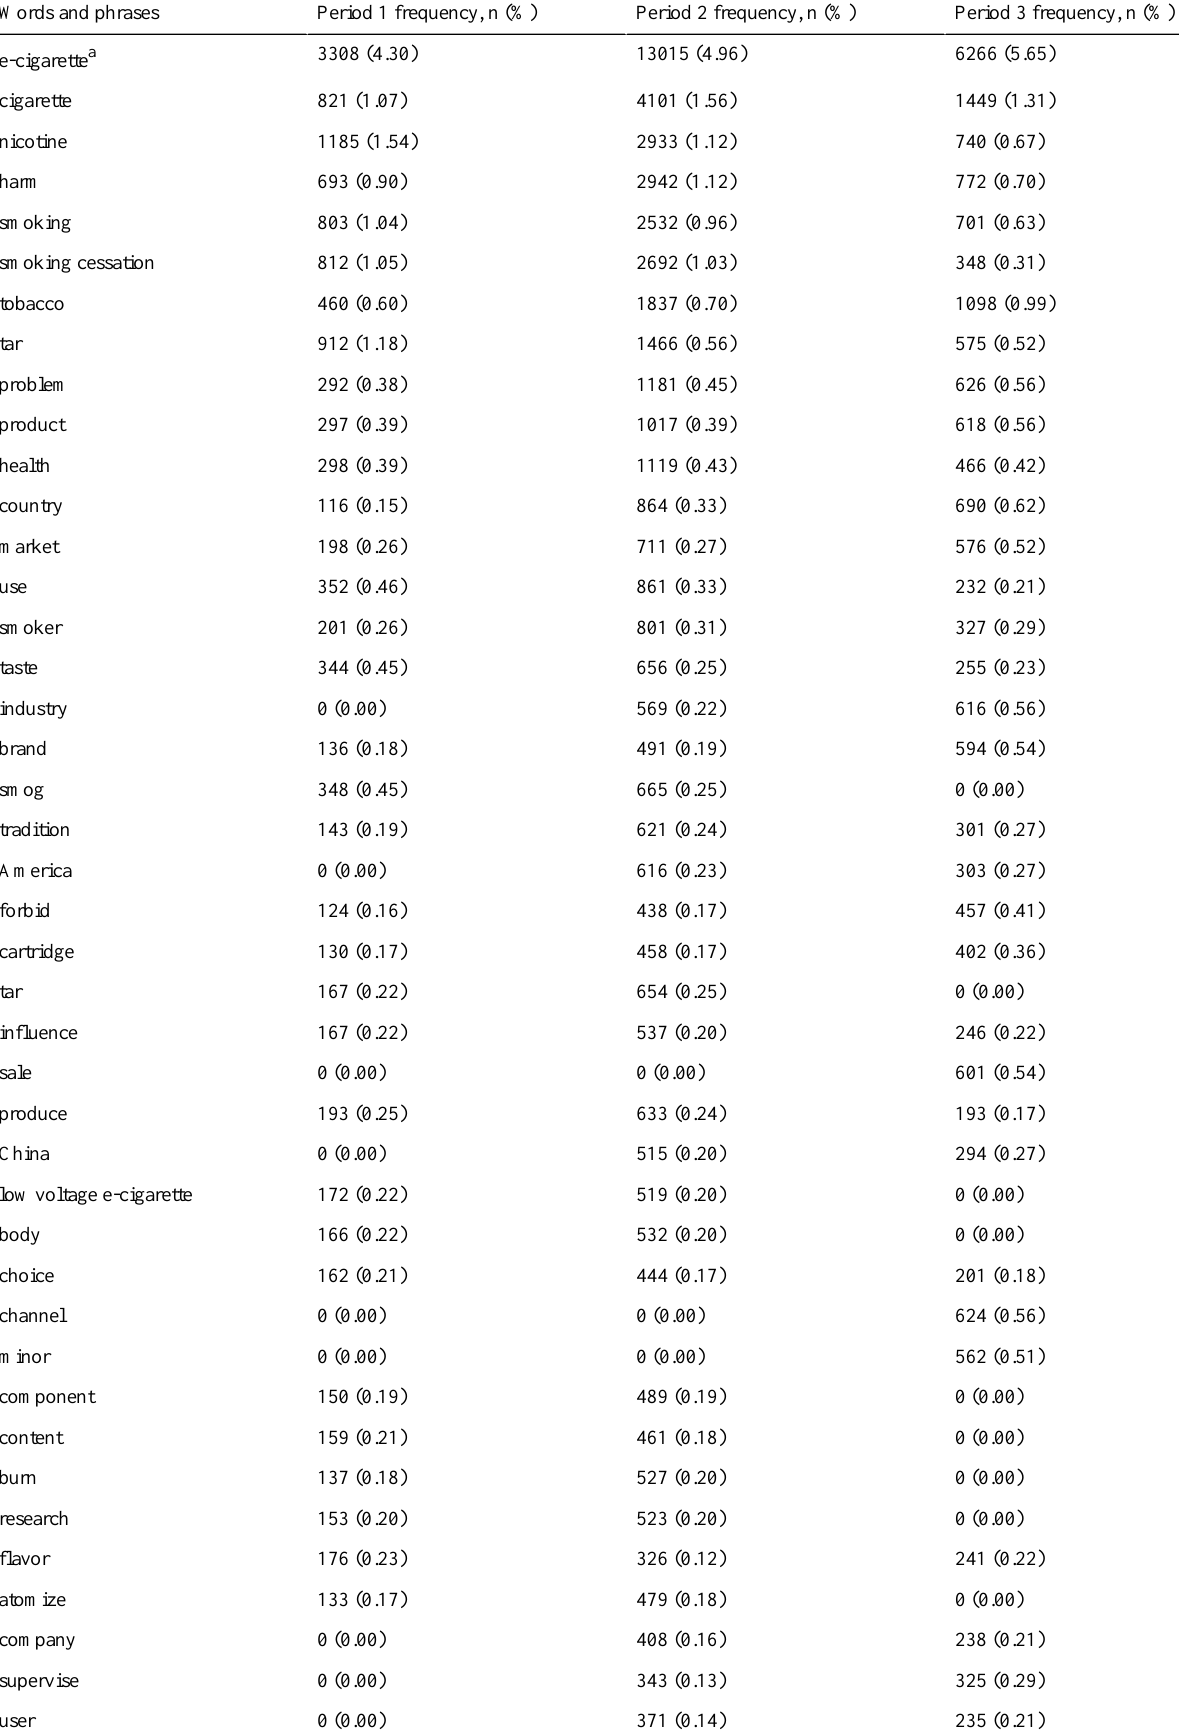
Table 2. The 3×50 contingency